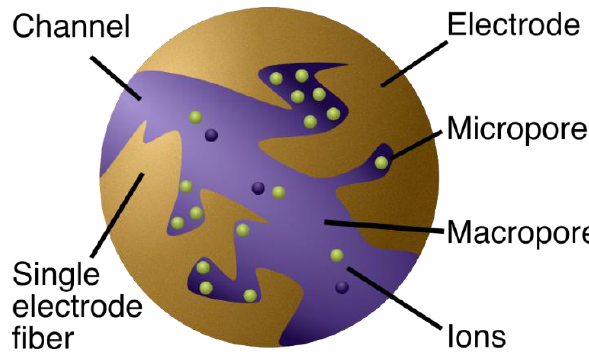
Figure 2. A schematic illustration showing a zoomed-in view (two carbon fibers from the knitted carbon cloth) of an electrode. The macropores in the electrode are the primary pathways for the water flow. Most of the ion adsorption occurs in the micropores because they carry most of the electrode area.